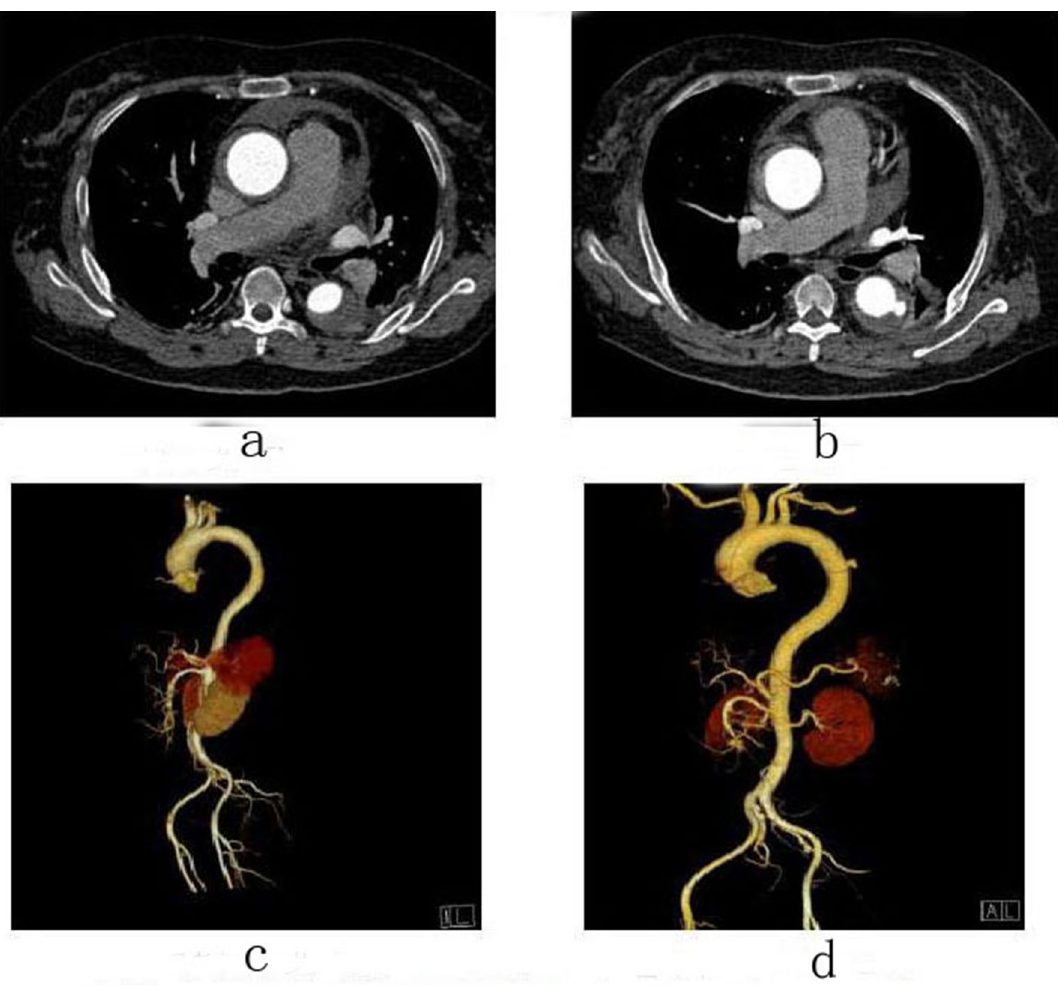
Figure 3. Female, 57 years old, admitted to hospital for “sudden pain in low back for 15 h”, Diagnosis: Stanford type A aortic dissection; treatment: IMH conservative treatment. CTA of the patient in different periods: ( a ) Admission; ( b ) 12 days after admission; ( c ) Admission; ( d ) 12 days after